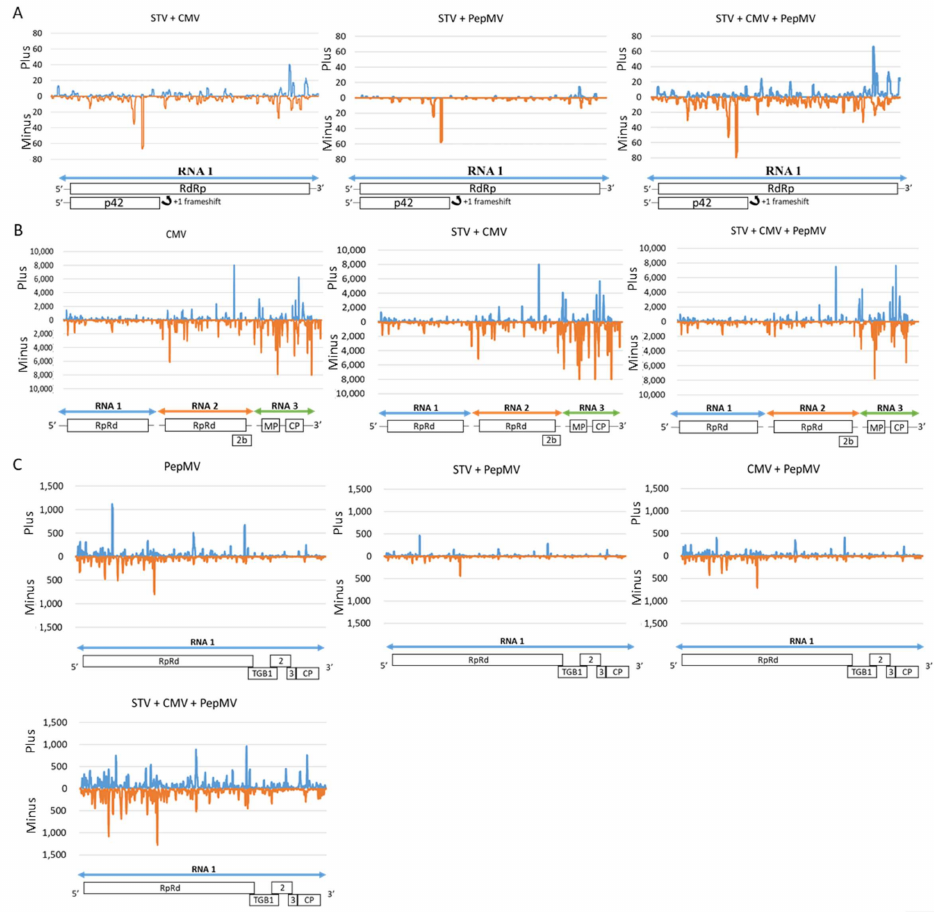
Figure 6. Graphical representation of plus (+) (blue) and minus ( − ) (orange) vsiRNAs frequencies along STV (Panel A ), CMV (Panel B ), and PepMV (Panel C ) genomes for the different virus combina- tions. Virus genome organization is showed in the bottom of each graph. STV and CMV vsiRNAs frequencies were not represented, since amounts of vsiRNAs were so low in STV-single infected and CMV + PepMV double- infected tomato